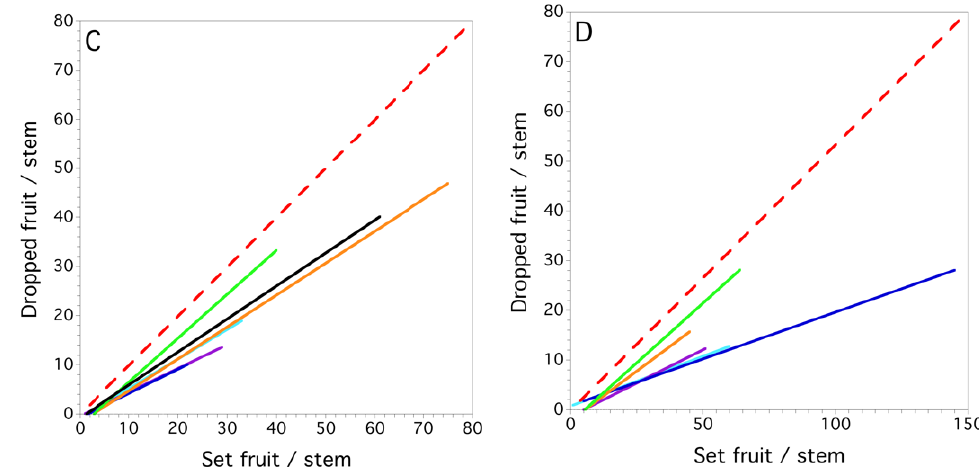
Figure 7. Maine, USA, wild blueberry linear proportional models for set fruit vs. dropped fruit (see methods for description of model: ( A ) 1996; ( B ) 1997; ( C ) 1998; and ( D ) 1999. Each field is a colored solid line. The red dashed line is the 1:1 relationship between set fruit and dropped fruit in which all set fruit are dropped, thus rendering no harvestable yield.